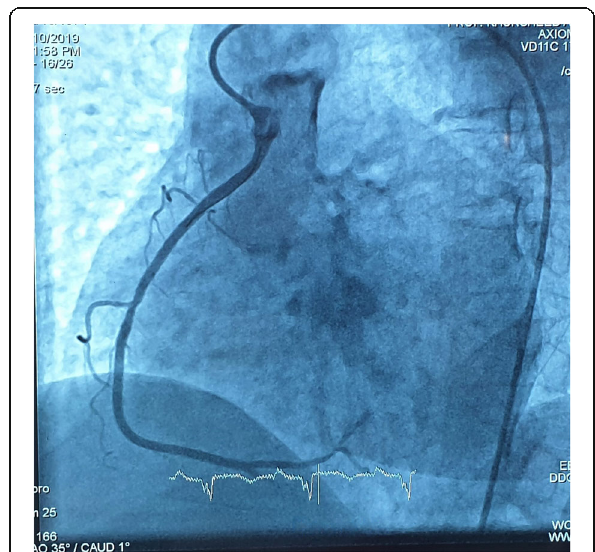
Fig. 4 Coronary angiogram showing TIMI 3 flow in RCA after the